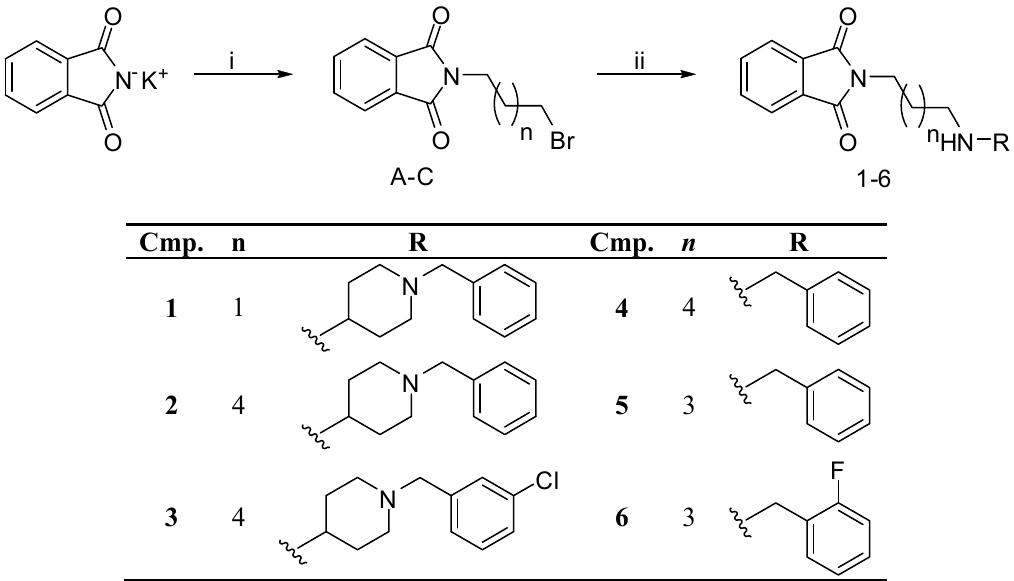
Figure 11. Reagents and conditions: i. dibromoalkane, tetra- n -butylammonium bromide (TBAB), MeCN, reflux, 20 h; ii. ( a ) 4-amino-1-benzylpiperidine, triethylamine (TEA), MeCN, reflux, 3 h (compound (cmp.) 1 , 2 ); ( b ) 1-(3-chlorobenzyl)piperidin-4-amine, TEA, MeCN, microwave (MW), 100 °C, 45 min. (cmp. 3 ); ( c ) benzylamine, K room temperature (RT), 48 h (cmp. 4 , 5 ); (d ) 2-fluorobenzylamine, K 48 h (cmp. 6